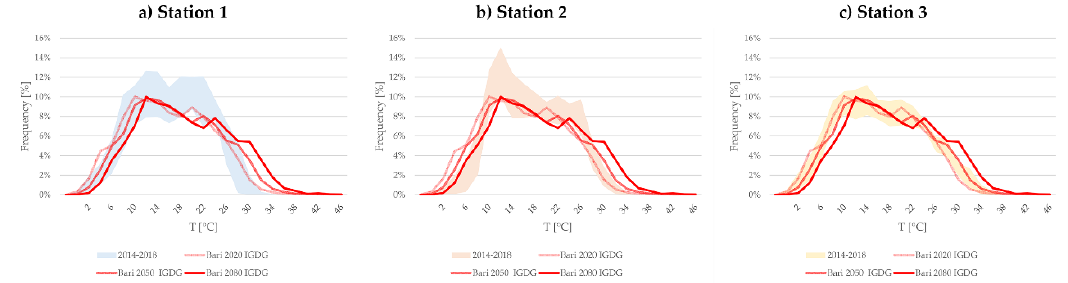
Figure 12. Frequency distribution of air temperature values recorded at station 1, 2, and 3 and comparison with the frequency distribution of air temperatures of future weather scenarios: ( a ) frequency distribution of air temperatures at station 1, ( b ) frequency distribution of air temperatures at station 2, ( c ) frequency distribution of air temperatures at station 3.